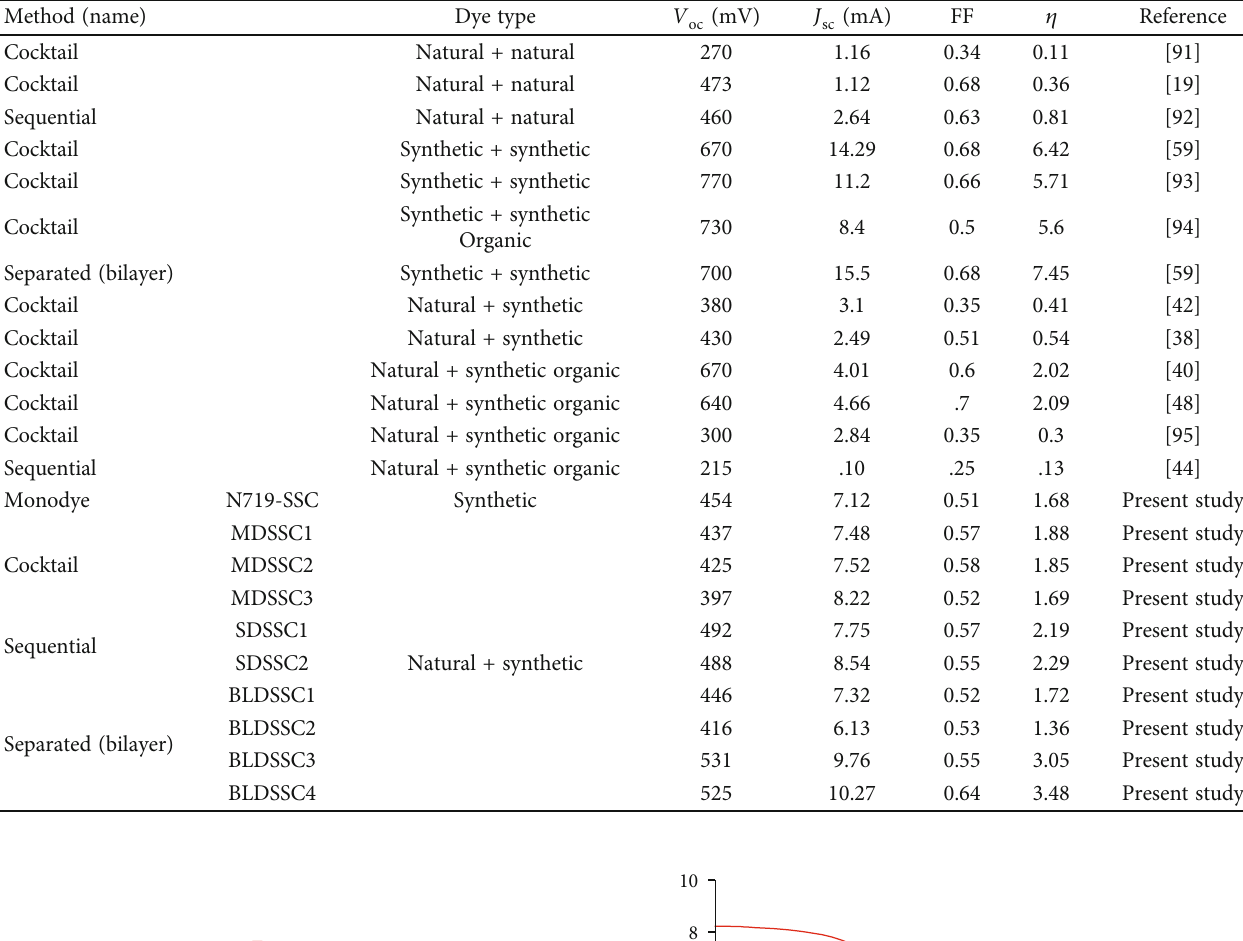
J Table 4: V oc , sc , FF, and e